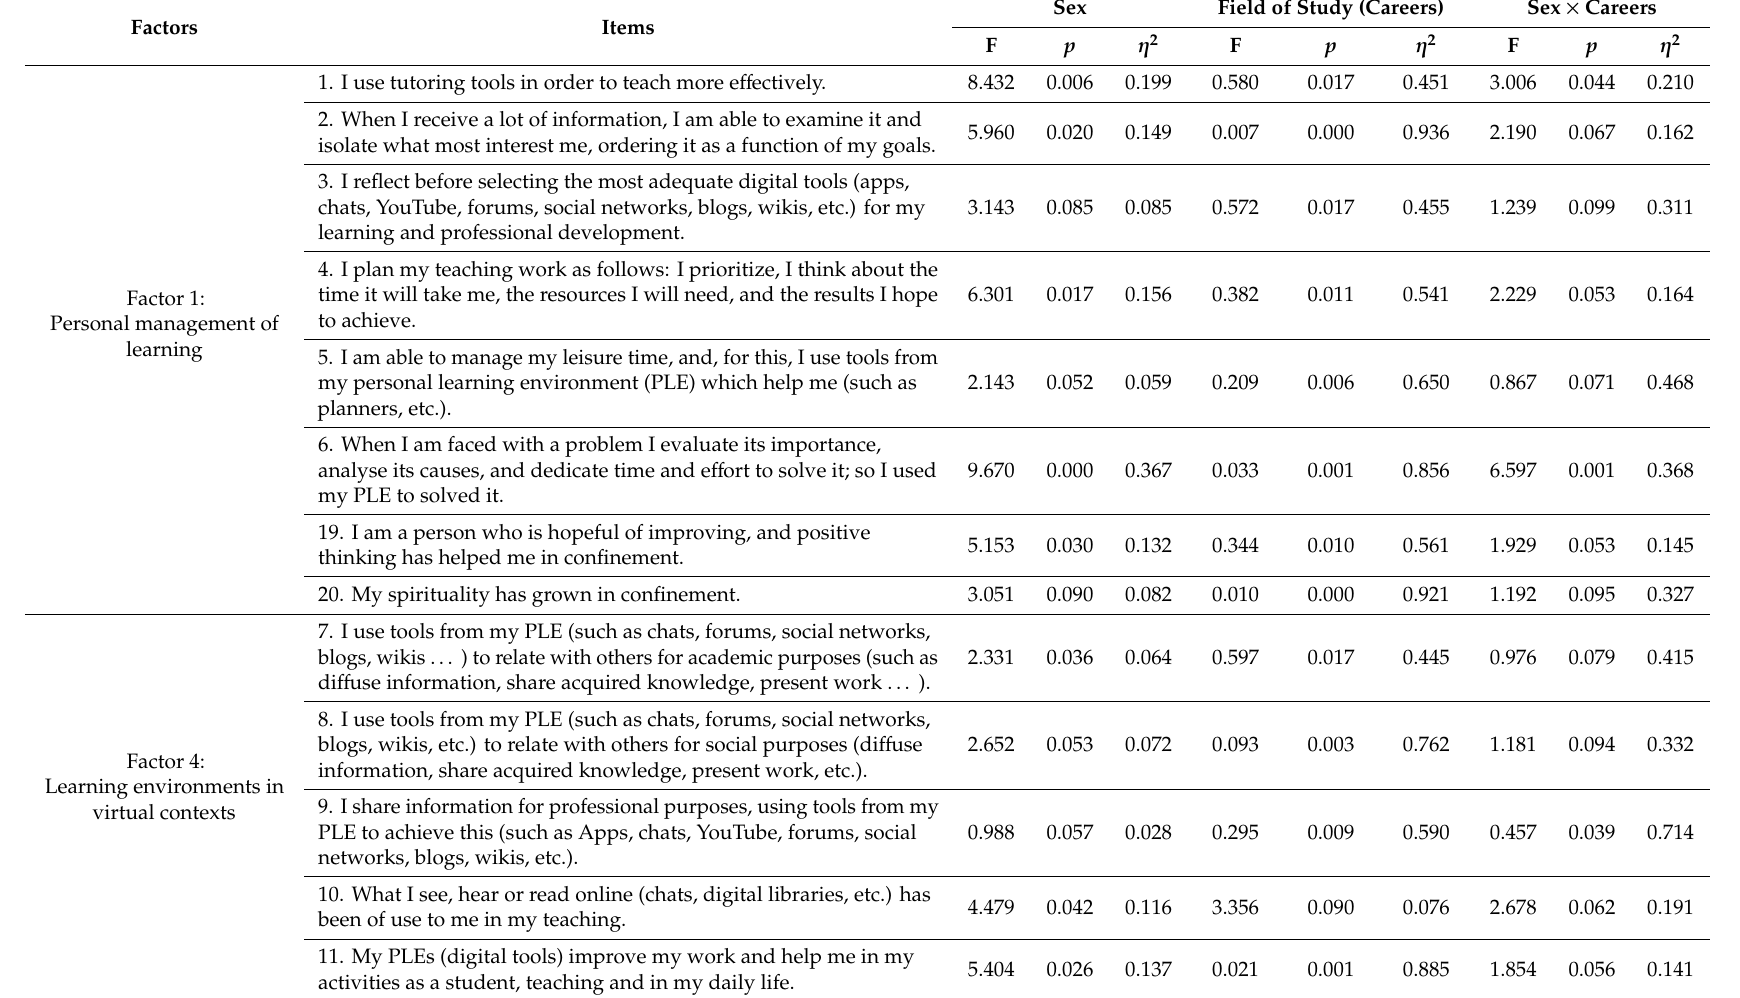
Table A2. ANOVA and e ff ect size ( η 2 ) for questionnaire QPLEC by sex and Field of study (Careers).